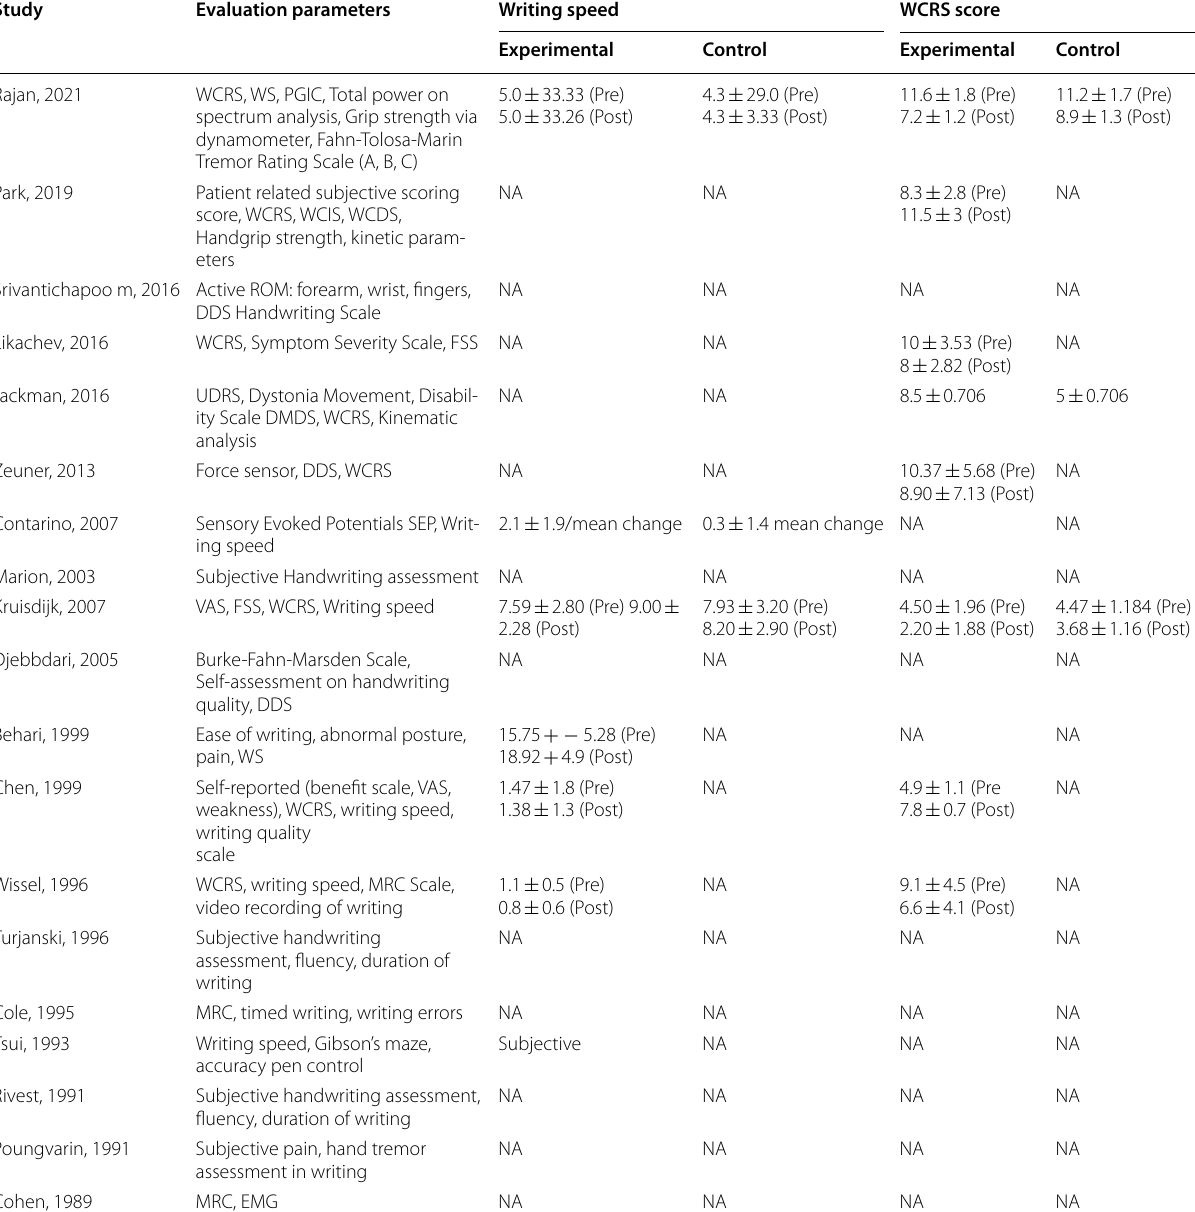
Table 2 Characteristics of outcome measures of included